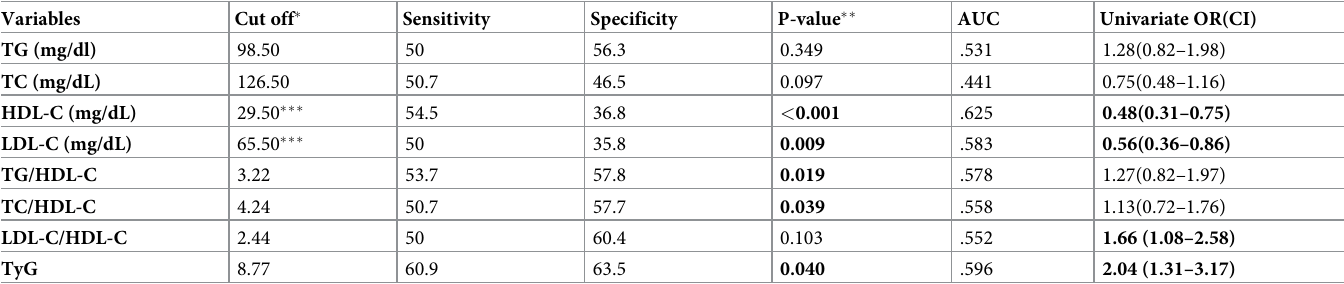
Table 4. Analysis of the ROC curve of the lipid profile, TyG index, and lipid ratios with mortality in patients with COVID-19.